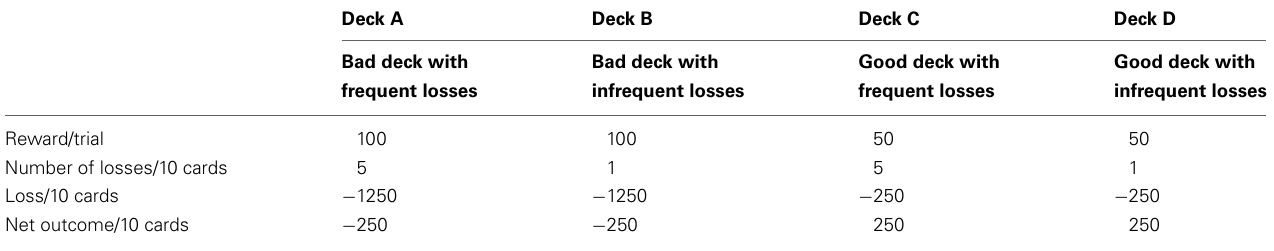
Table 1 | Payoff scheme of the traditional IGT as developed by Bechara et al.